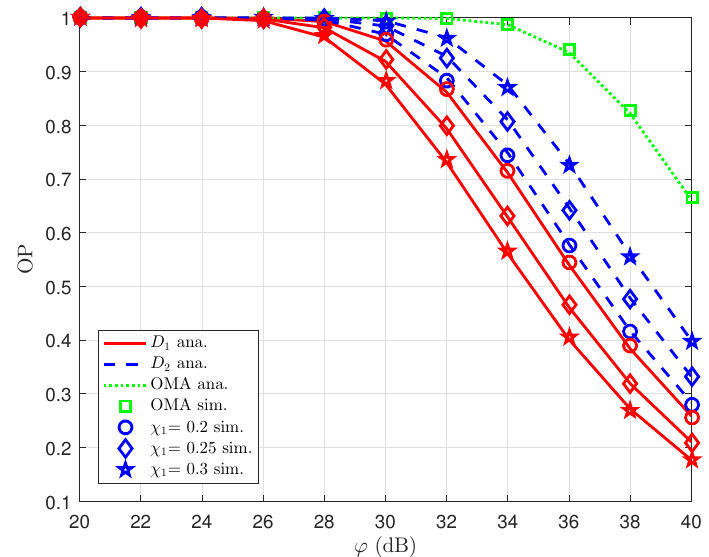
Figure 3. OP versus ϕ for different χ 1 .